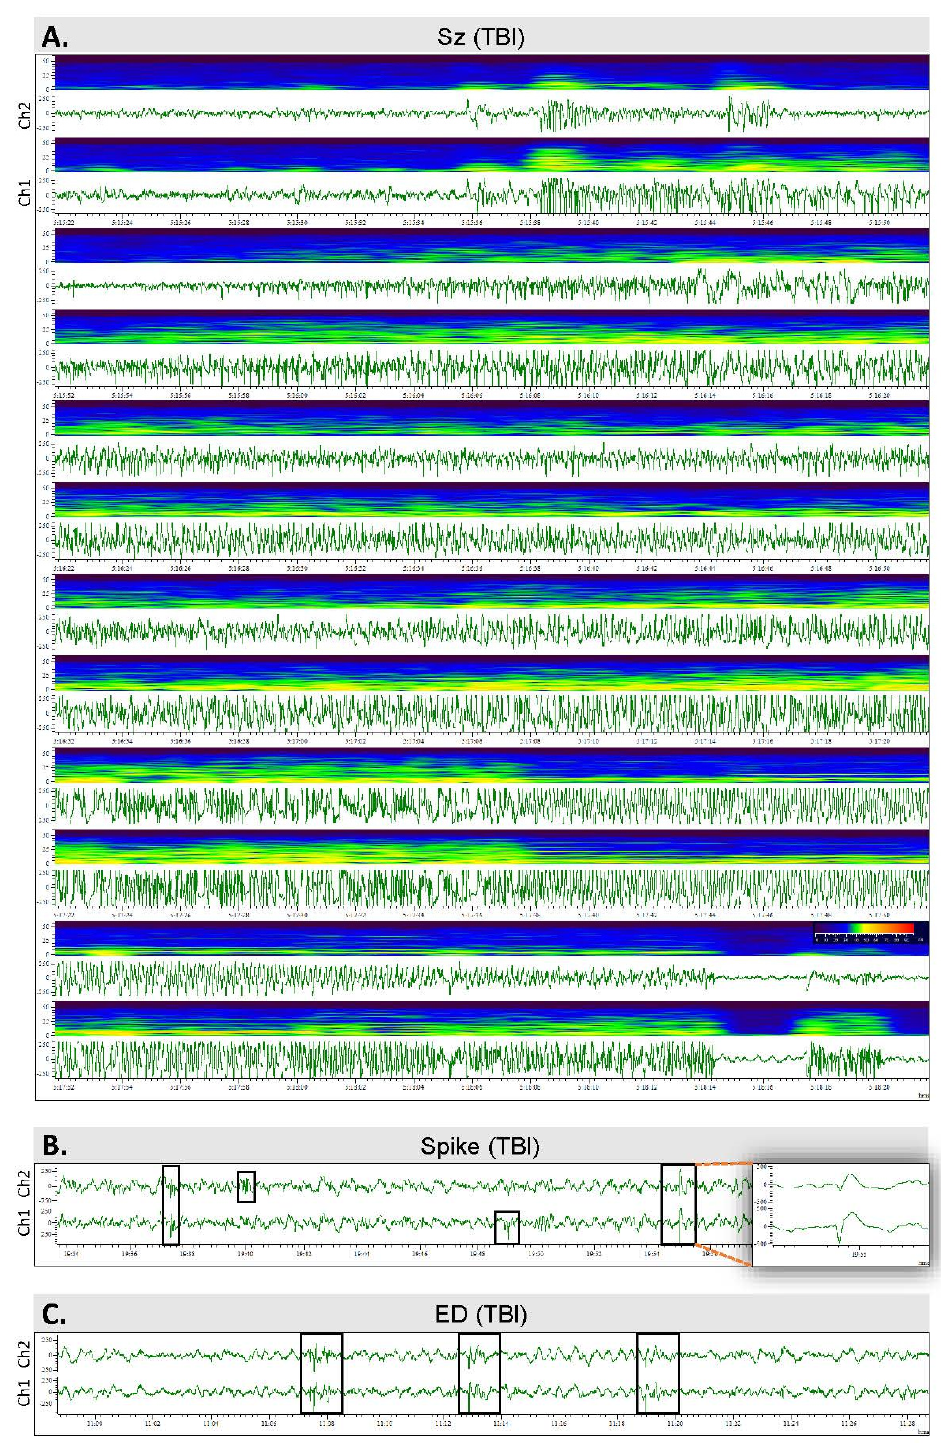
Figure 4. Spontaneous epileptiform activity: ( A ) An unprovoked spontaneous seizure in a TBI rat #36. The seizure started at the N3–REM transition and lasted for 166 s. ( B ) Epileptiform spikes in a TBI rat #36. The insert on the right shows the spike with a higher resolution. ( C ) Epileptiform discharges (EDs) in a TBI rat (#36).